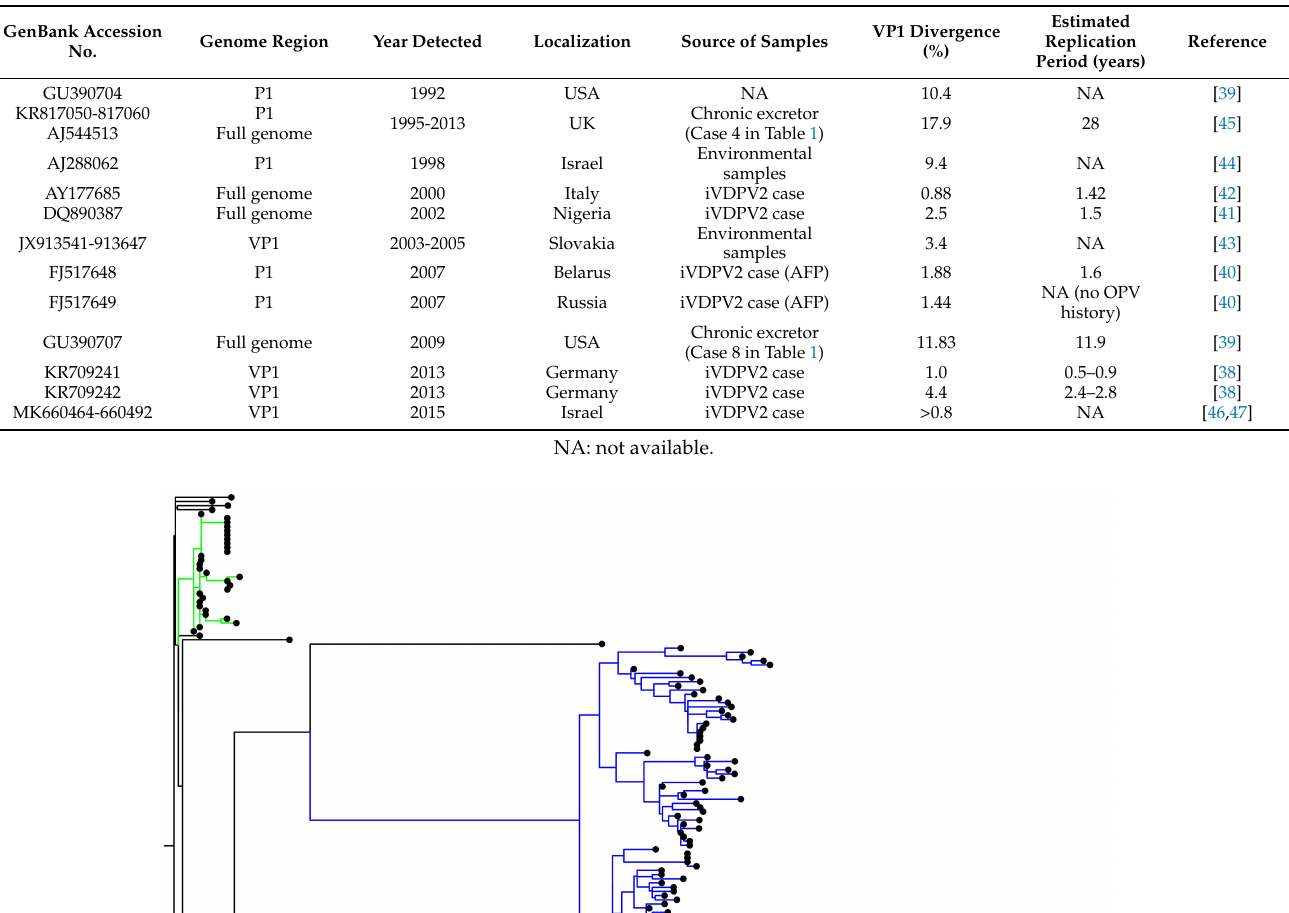
Table 2. Sequence dataset of probable type 2 iVDPV strains.